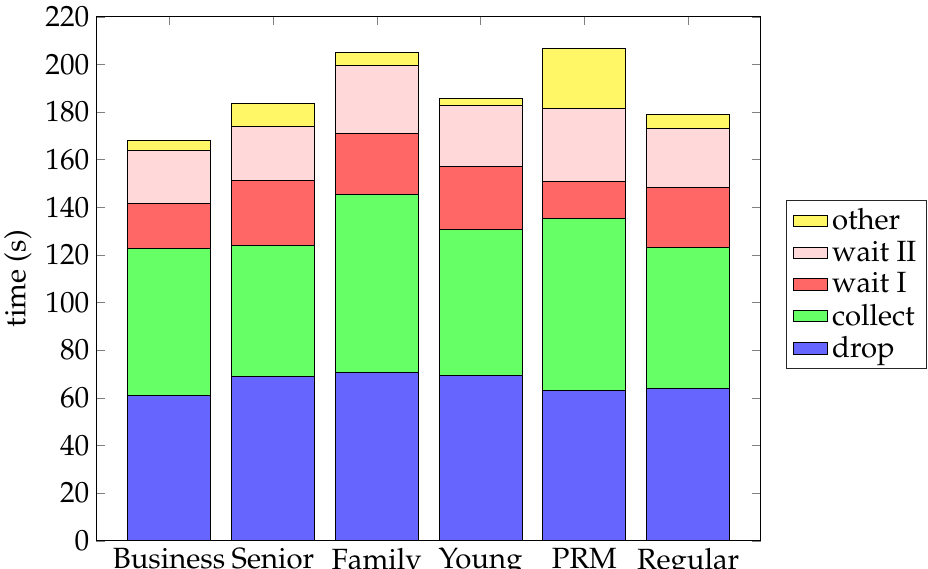
Figure 3. The mean processing times, split into five subprocesses, for each of the passenger types in the